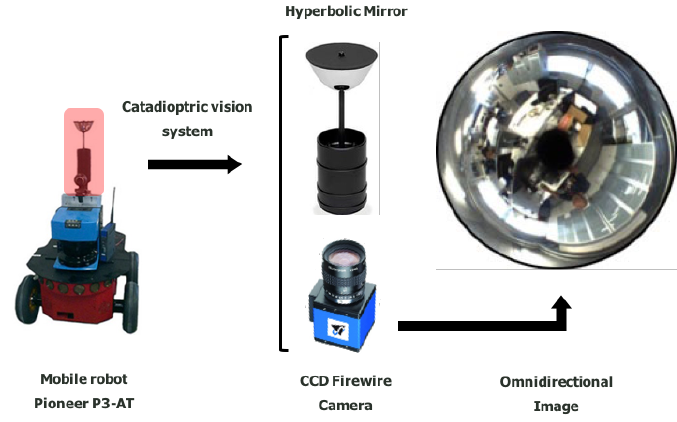
Figure 1. Real equipment constituted by a Pioneer P3-AT robot equipped with an internal odometer, a SICK-LMS200 laser range finder, and a catadioptric vision system, namely an omnidirectional vision system. This vision system is composed of a CCD (Charge-Coupled Device) FireWire DMK21BF04 camera, assembled with a hyperbolic Eizo h Wide 70